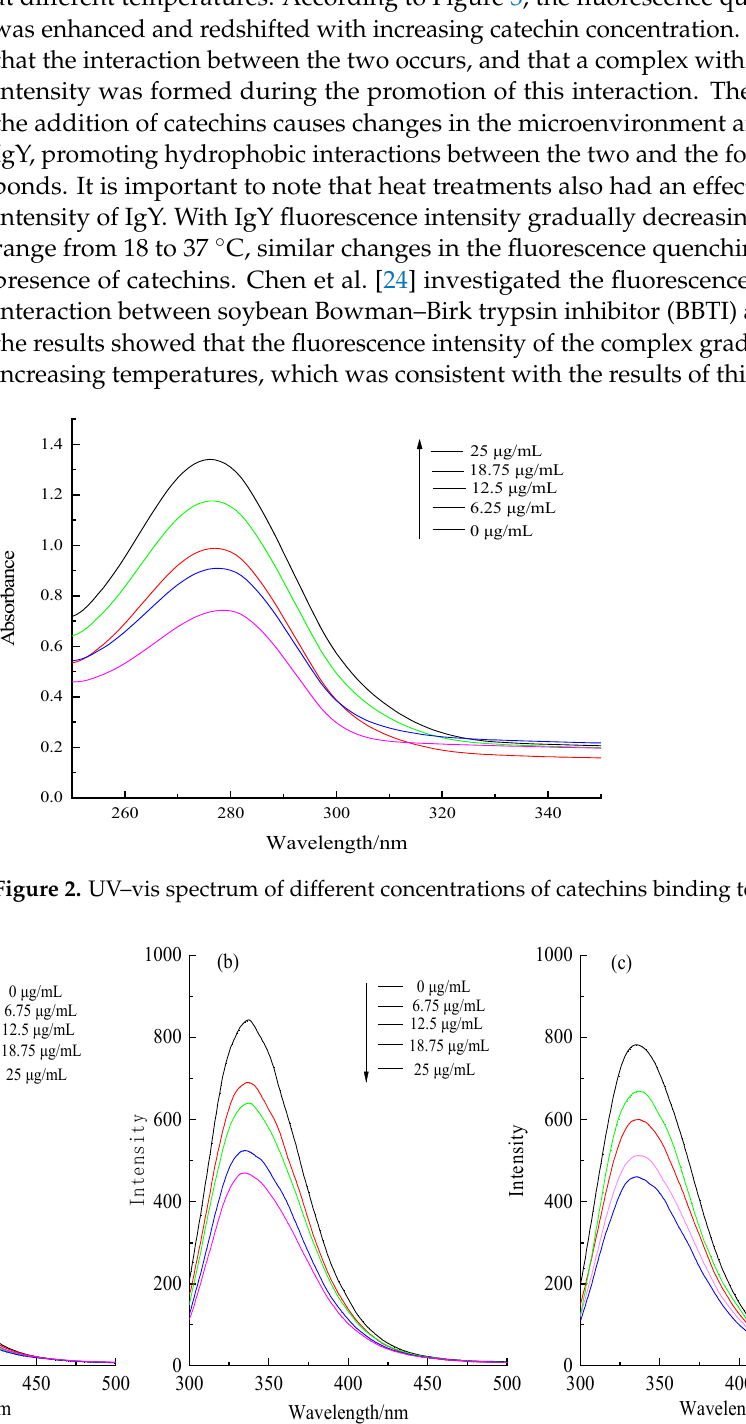
Figure 3. Fluorescence spectra of different concentrations of catechins binding to IgY. ( a ) 18 °C, ( b ) 25 °C, ( c ) 37 °C.